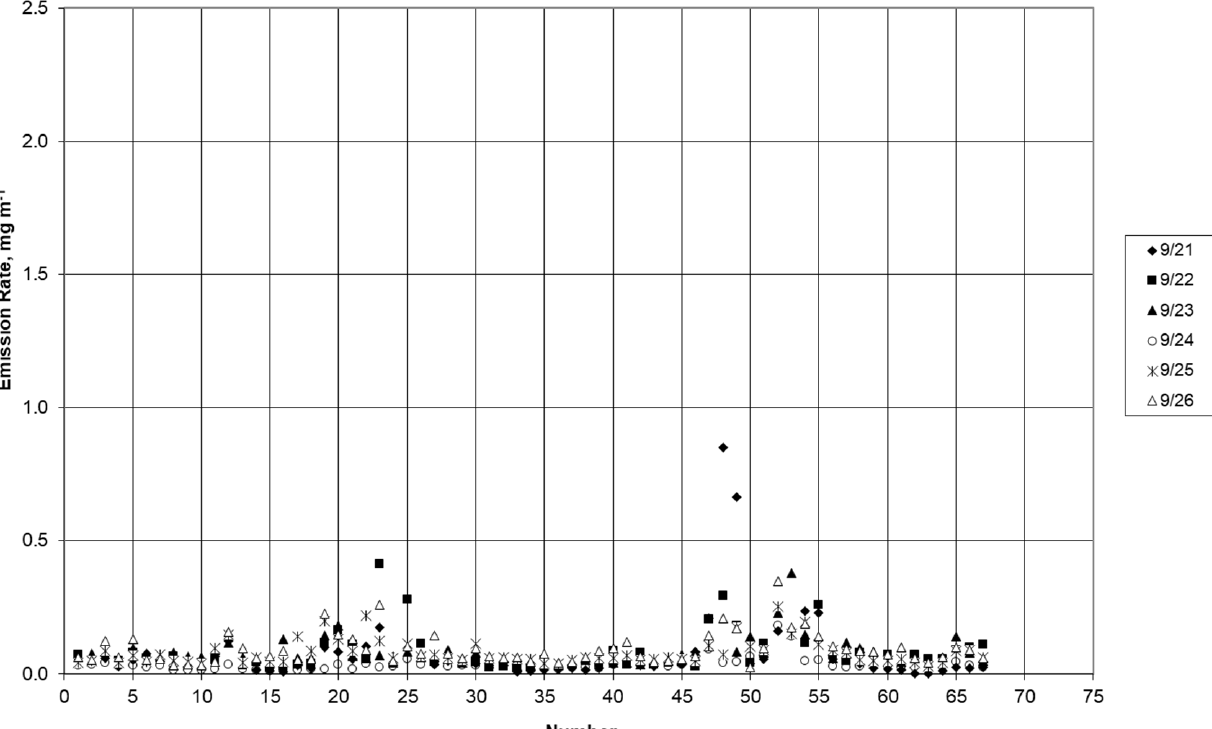
Figure 5. Plot of PM 10 emission rate by segment number starting Monday, 19 June.